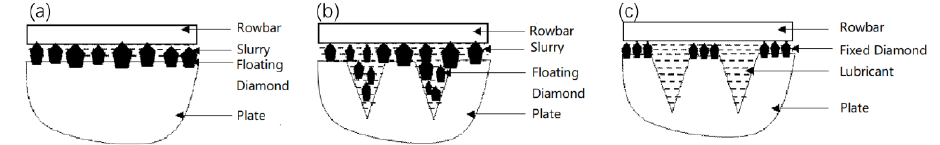
Figure 6. Comparison of different grinding methods: ( a ) traditional grinding process; ( b ) float grinding process; ( c ) novel float grinding process.